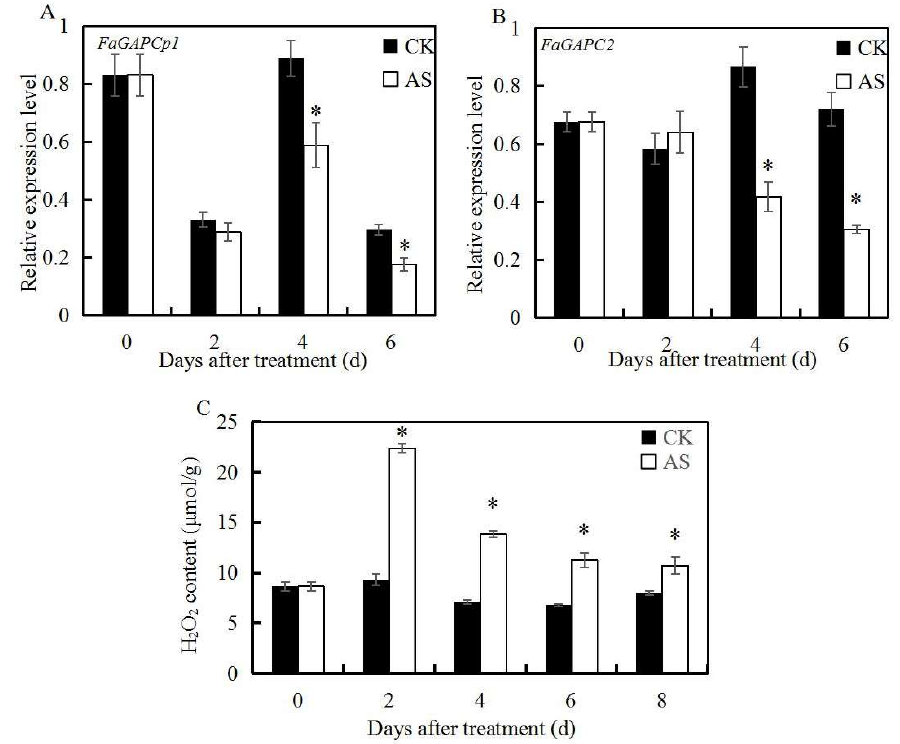
Figure 2. qRT-PCR analysis of FaGAPC2 and FaGAPCp1 genes and H 2 O 2 content after abscisic acid (ABA) and sucrose treatment. ( A ) Changes in FaGAPCp1 transcript levels in ABA + sucrose-treated fruit during the development and ripening of strawberry fruit; ( B ) changes in FaGAPC2 transcript levels in ABA + sucrose-treated fruit during the development and ripening of strawberry fruit; ( C ) changes in H 2 O 2 content in ABA + sucrose-treated fruit during the development and ripening of strawberry fruit. Strawberry was treated with 95 µ M ABA + 100 mM sucrose (AS) and distilled water (CK) at the de-greening stage, respectively. Values are means ± SD of three biological replicates. Asterisks indicate statistically significant di ff erences at p ≤ 0.05 as determined by Student’s t